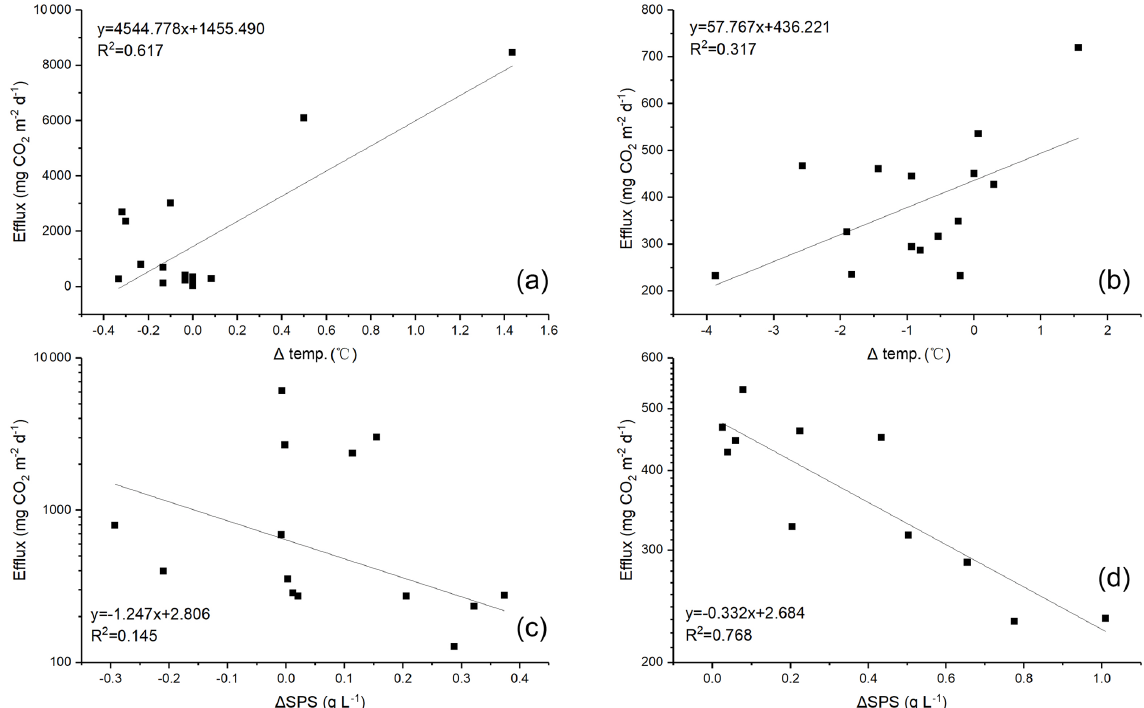
Figure 10. Positive correlations between water temperature gradient (TR1-P1 or TR2-P4) and measured effluxes at points R1 ( a , p < 0 . 01) and R2 ( b , p < 0 . 05), and the negative correlations between suspended sediment (SPS) concentration gradient (SPS R1-P1 or SPS R2-P4) and measured effluxes at R1 ( c , p < 0 . 01) and R2 ( d , p < 0 . 01). The gradient in water temperature and SPS concentration reflects the difference of properties between inflow and receiving waterbody and determines the mixing mode. Colder and more turbid inflow has a higher density than the receiving water and thus forms an underflow or subsurface flow (hyperpycnal flow). When the inflow was warmer, clearer and lighter than the receiving waterbody, the inflow can form a surface flow (hypopycnal flow) and flow over the reservoir surface, releasing allochthonous carbon to the